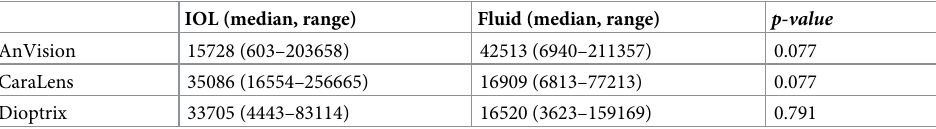
Table 1. Read counts for each intraocular lens/packaging fluid